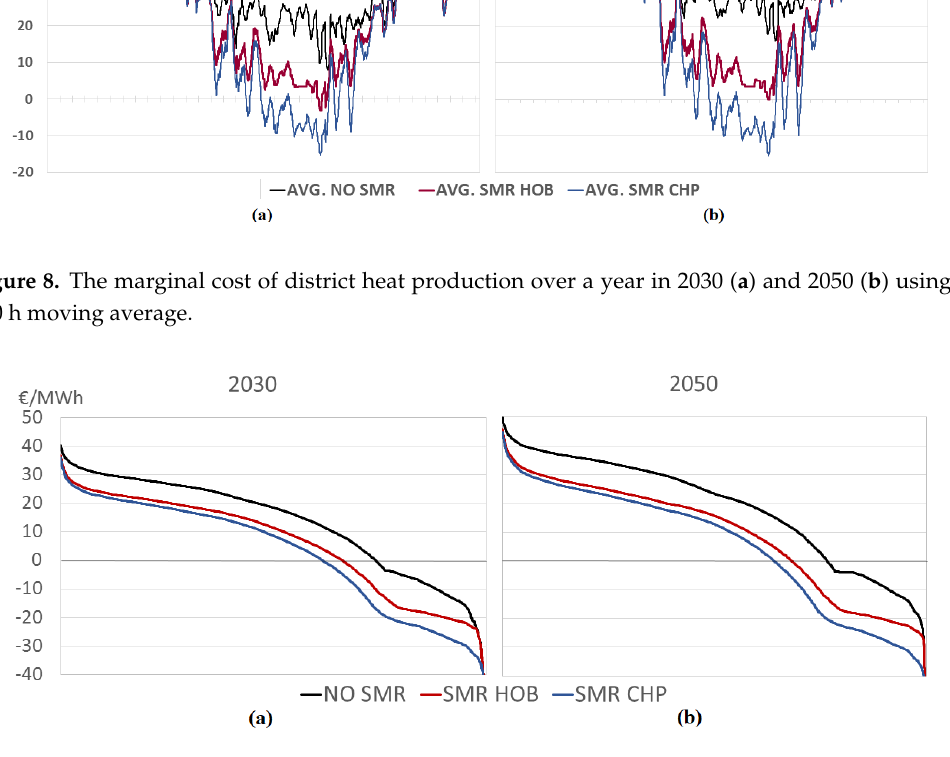
Figure 9. The sorted average hourly production costs over a year in 2030 ( a ) and 2050 ( b